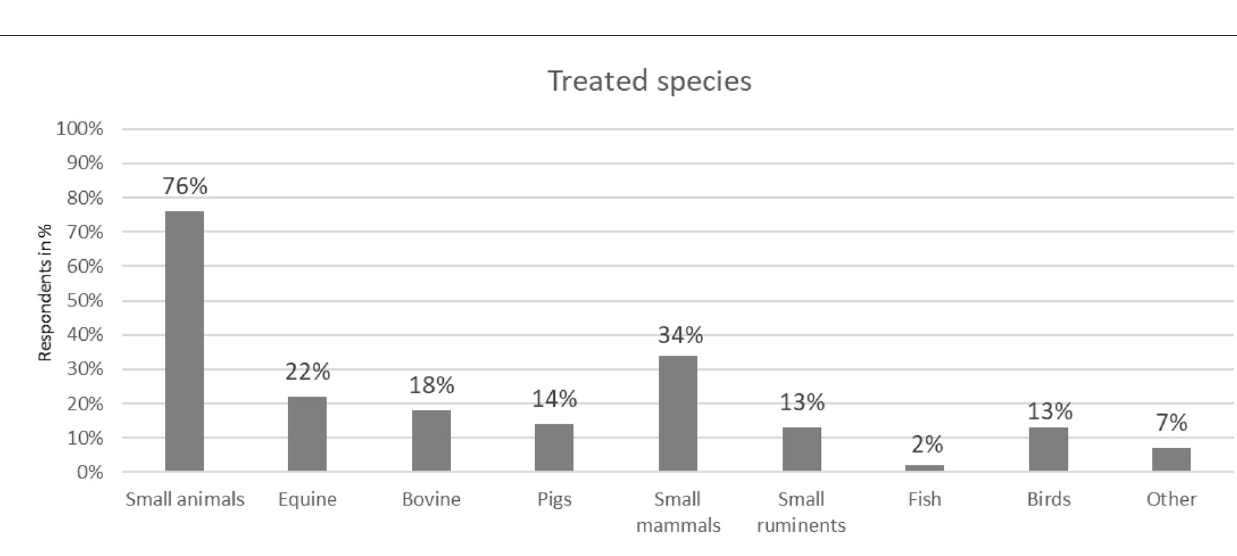
( n = 22, 13 %) and clinics ( n = 22, 13 %) and a small number did not work in any practice ( n = 4, 2.4 %) (Figure